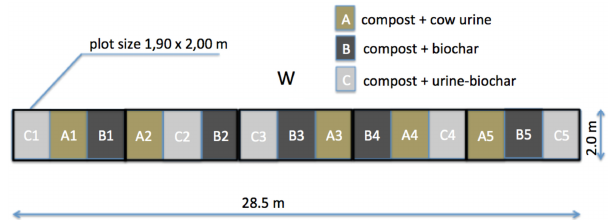
Figure 1. Trial set-up. Notes: Experimental set-up consisting of five randomized blocks. Each plot contained one pumpkin plant. The same set-up was used at each trial location, with three to five randomized